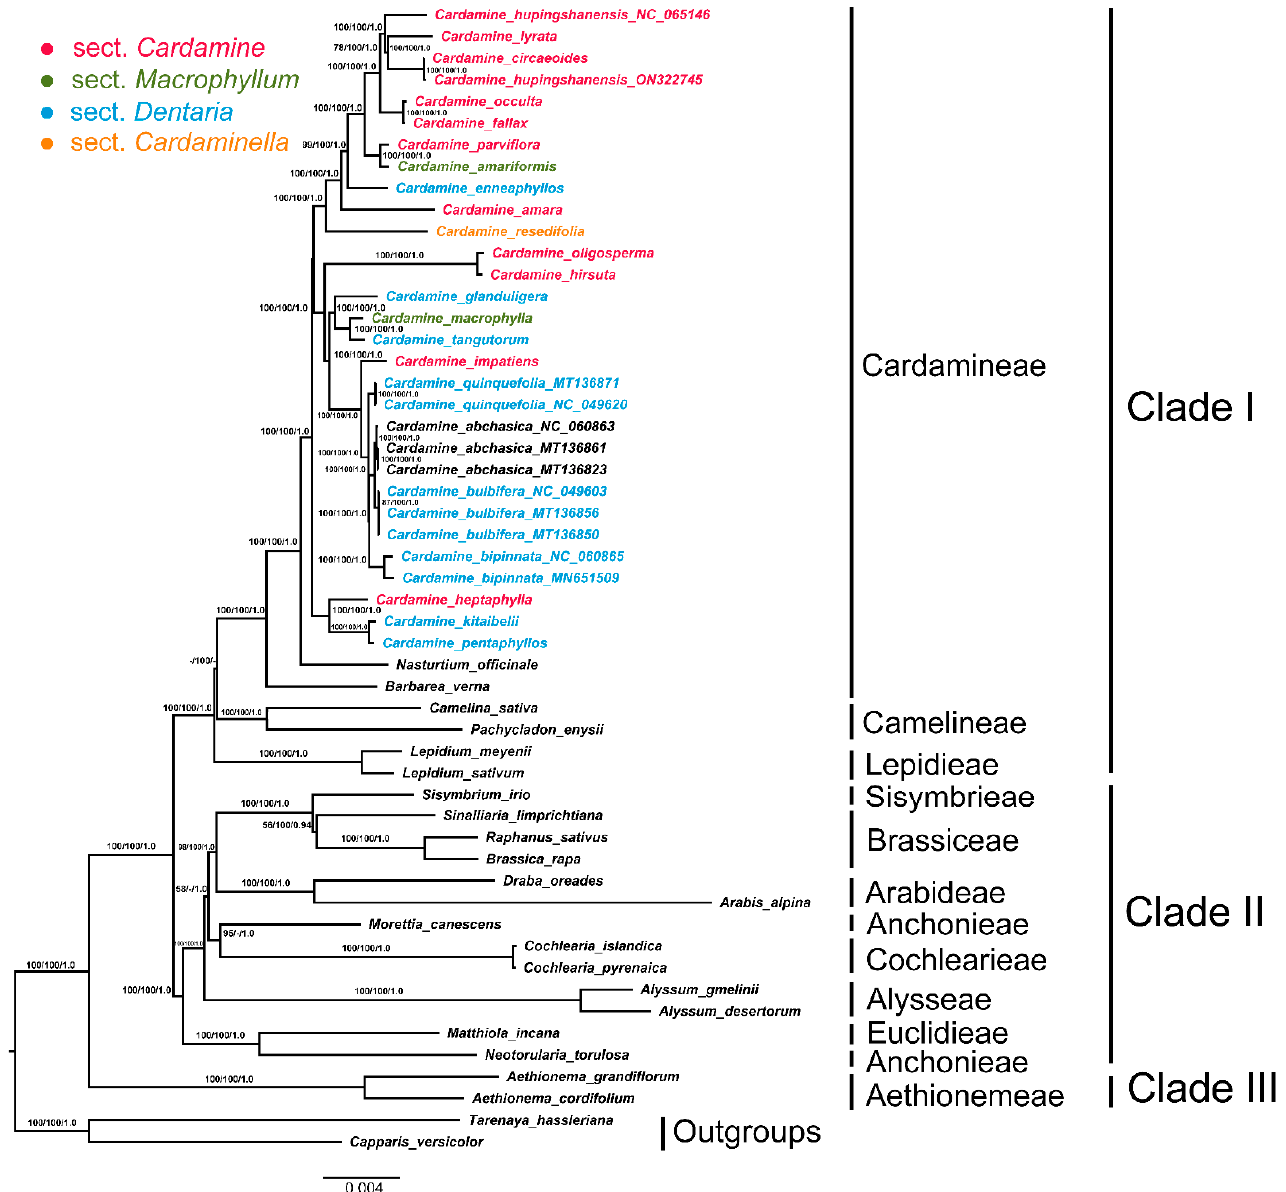
Figure 6. The maximum likelihood (ML) tree of Brassicaceae. Numbers associated with branches are ML bootstrap values, MP bootstrap values and Bayesian posterior probabilities, respectively. Hyphens indicate the bootstrap support or posterior probability lower than 50% or 0.5. Tarenaya hassleriana (KX886354) and Capparis versicolor (MH142726) were used as outgroups.